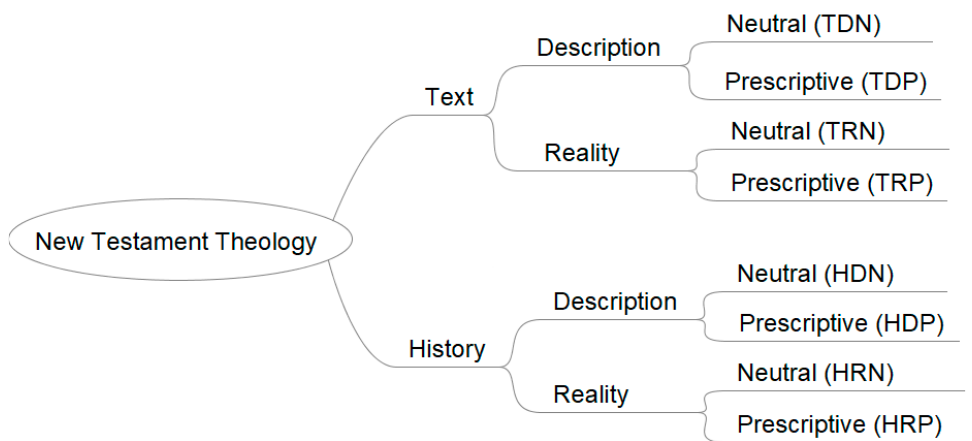
Figure 1. Typology of NTT subject matter.